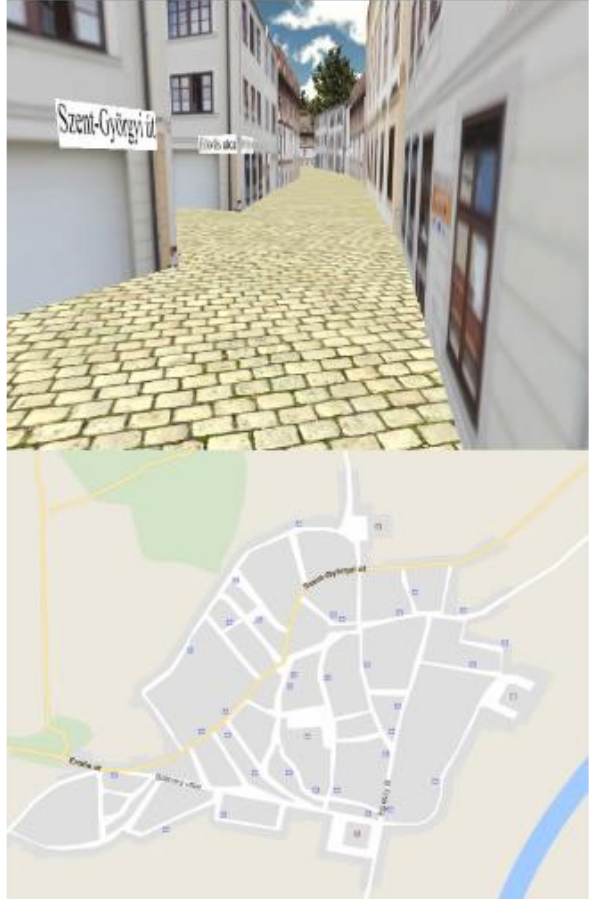
Figure 3. The layout of the VR experiment on